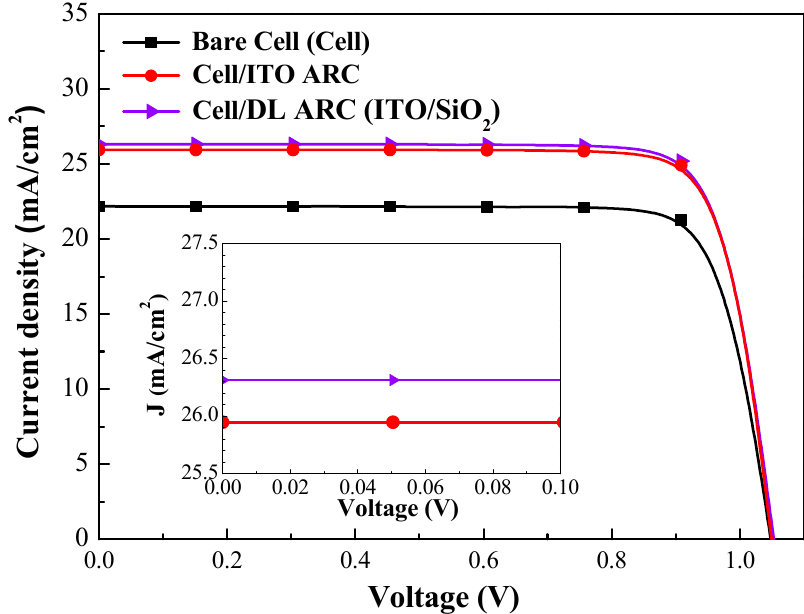
Figure 10. Photovoltaic J-V curves of a bare-type GaAs single-junction solar cell and cells coated with layer of ITO or ITO/SiO 2 .